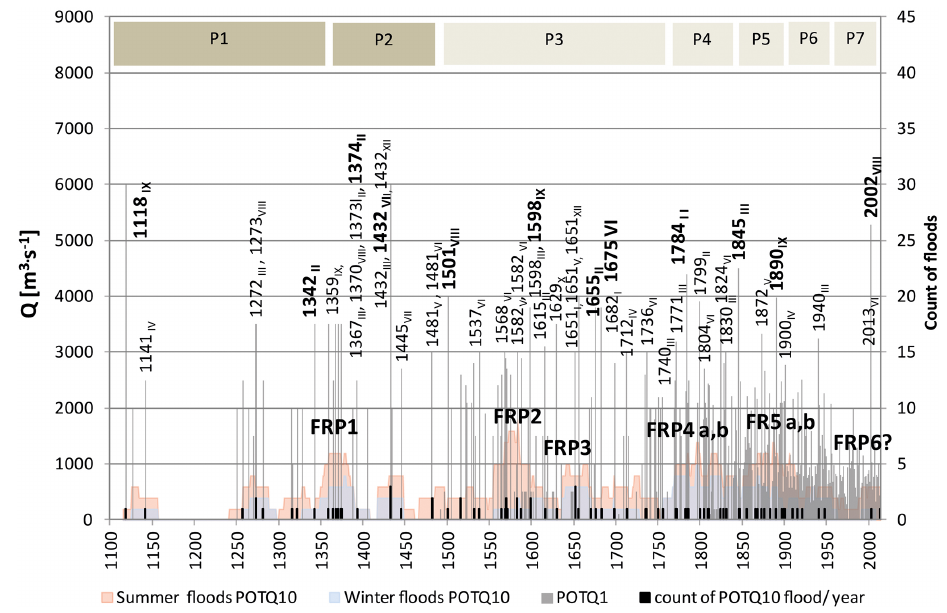
Figure 3. Final time series presenting running 31-year frequencies in summer and winter floods in Prague with identification of flood-rich periods, the extreme floods are in